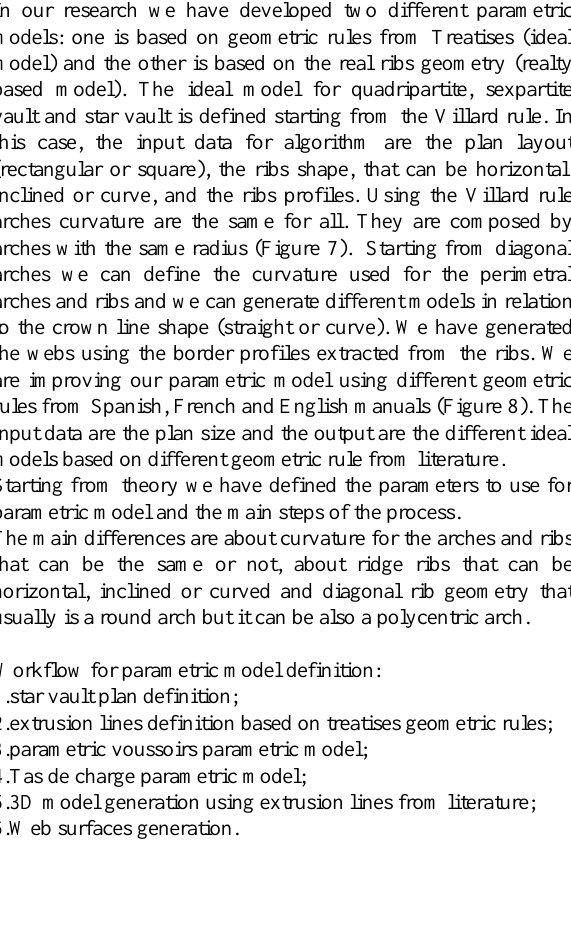
Figure 8 . Five keystones vault: different geometric rules from literature. From square to rectangular plan. From horizontal ridge to curved